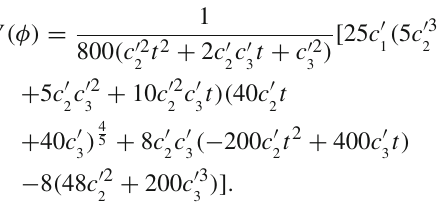
Fig. 2 Plots of Hubble H ( t ) ( left ) and EoS parameters ω eff ( right ) versus cosmic time